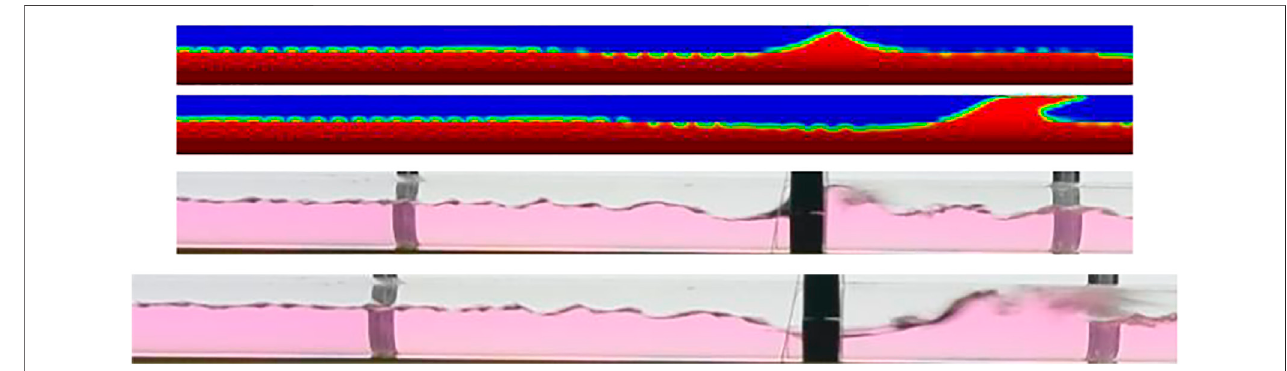
FIGURE 11 | Comparison between simulations and experiments of the slug formation process at the pipe entrance (Vsg (cid:2) 2 m/s, Vsl (cid:2) 0.2 m/s).